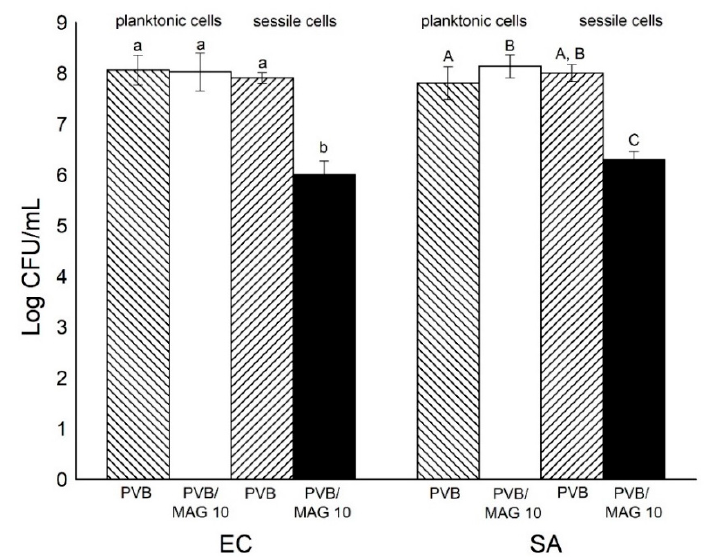
Figure 9. Bacterial adhesion test (antifouling activity): the numbers of viable bacteria Escherichia coli (EC) and Staphylococcus aureus (SA) in planktonic and sessile mode determined after the contact time (24 h) with the PVB or PVB/MAG 10 membranes. The various lowercase and uppercase letters indicate significant differences ( p < 0.05) between the samples tested against EC and SA, respectively.